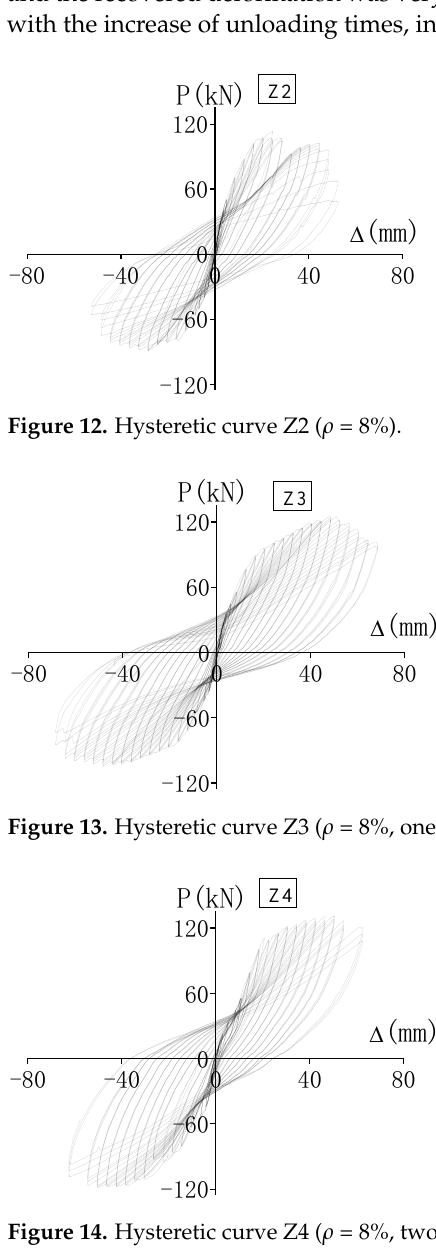
Figure 11. Hysteretic curve Z1 ( ρ = 0).